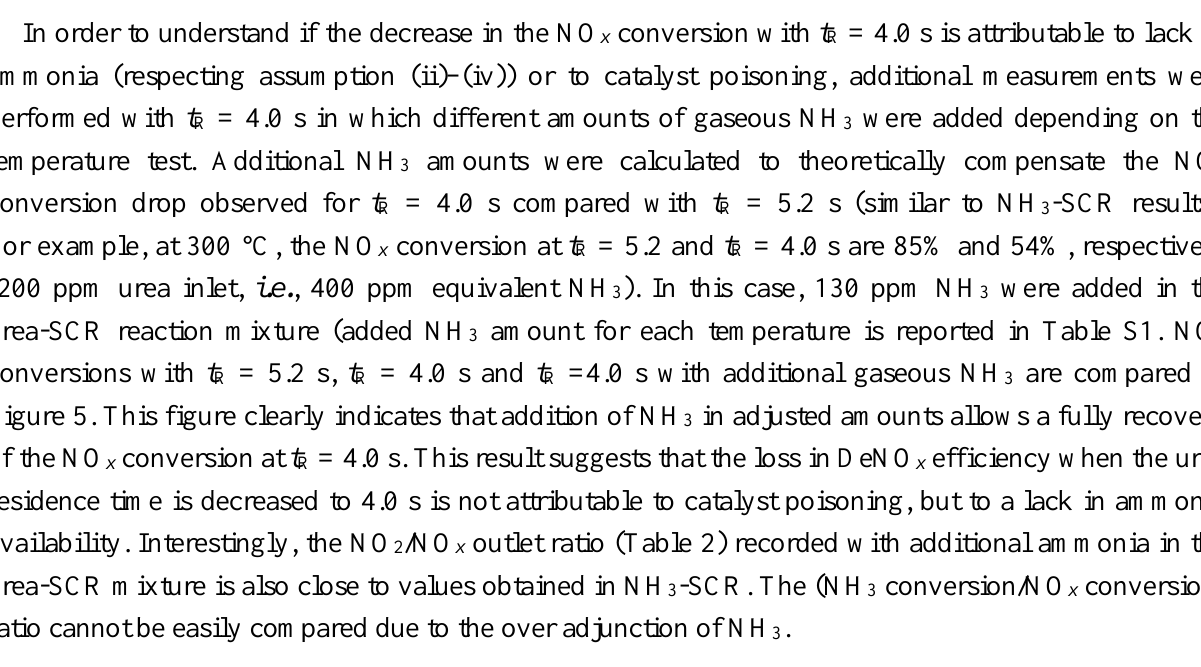
Figure 4. (▬): NH 3 -TPD experiments under N 2 ; (▬): urea-TPD experiments under N 2 ; (▬): urea-TPO experiments under 8% H 2 O, 10% CO 2 , 10% O 2 after urea adsorption at 175 °C from 1